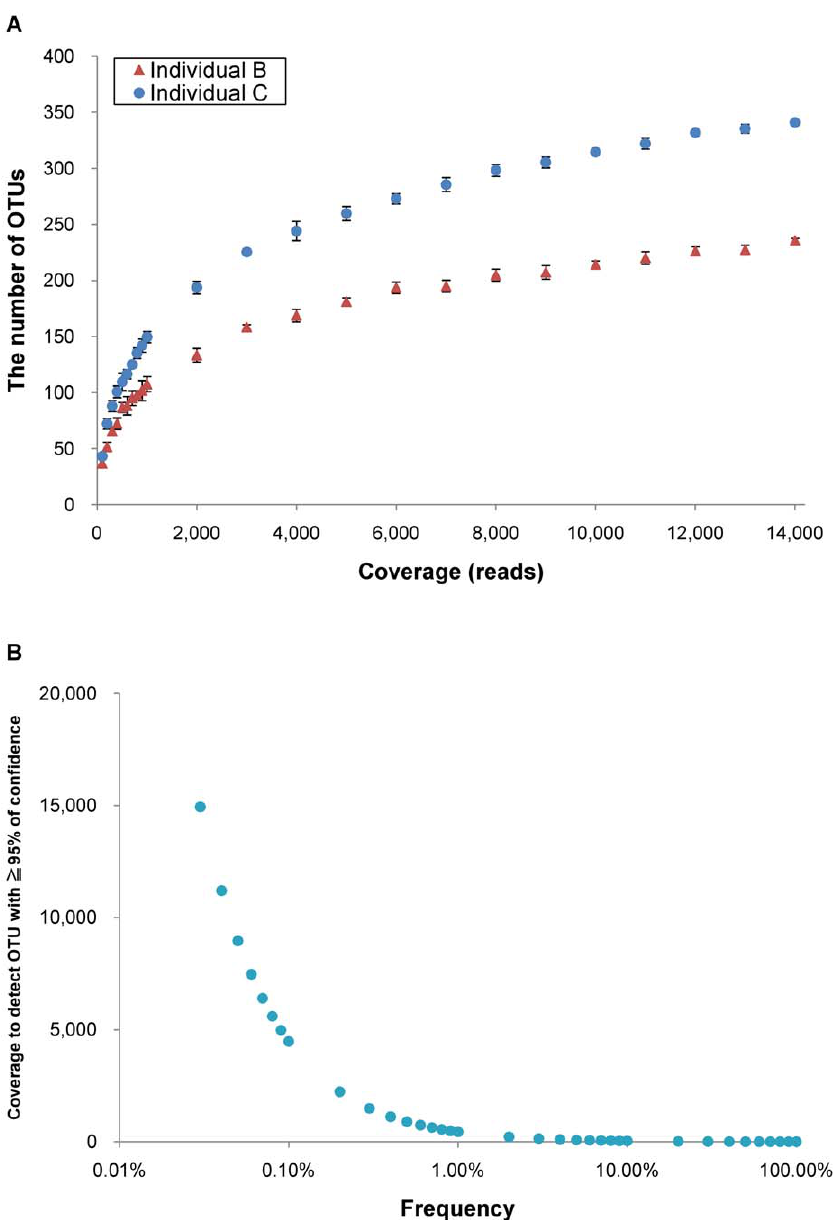
Figure 2. Association between coverage and the number of OTUs. (A) The number of OTUs sampled as a function of number of reads. The data points represent mean 6 SD of five randomized samplings. (B) Coverage to detect OTU with different frequencies with $ 95% of confidence. The data points were estimated based on the binomial distribution (see Materials and Methods). The x axis is shown in logarithmic scale.